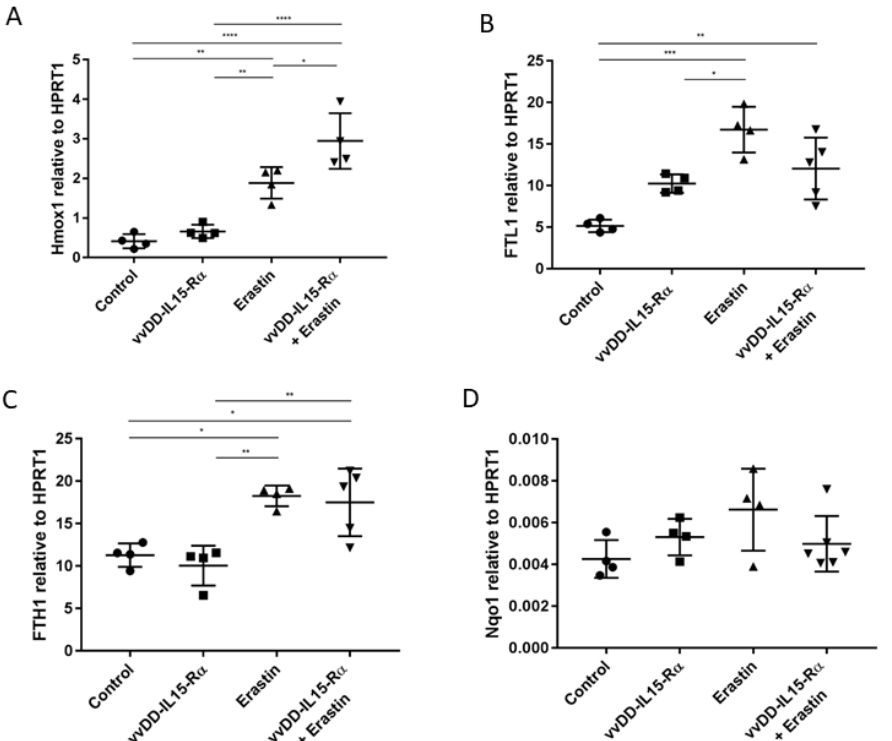
Figure 3. The combination of erastin and vvDD-IL-15-R α also induced ferroptosis markers in MC38- luc colon cancer cells. MC38-luc cells were plated at 6.0 × 10 4 /well in a 24-well plate and infected with vvDD-IL15-R α (MOI = 0.1) and/or erastin (1.0 µ m) the next day. After 24 h, cells were collected and cell lysates were used to extract RNA to determine the expression levels of Hmox1, FTL1, FTH1, and Nqo1 ( A – D ). The expression levels of all markers are relative to the housekeeping gene HPRT1. Values are mean ± SD. One-way ANOVA was used to analyze the statistical significance (*, p < 0.05; **, p < 0.01; ***, p < 0.001; ****, p < 0.0001).